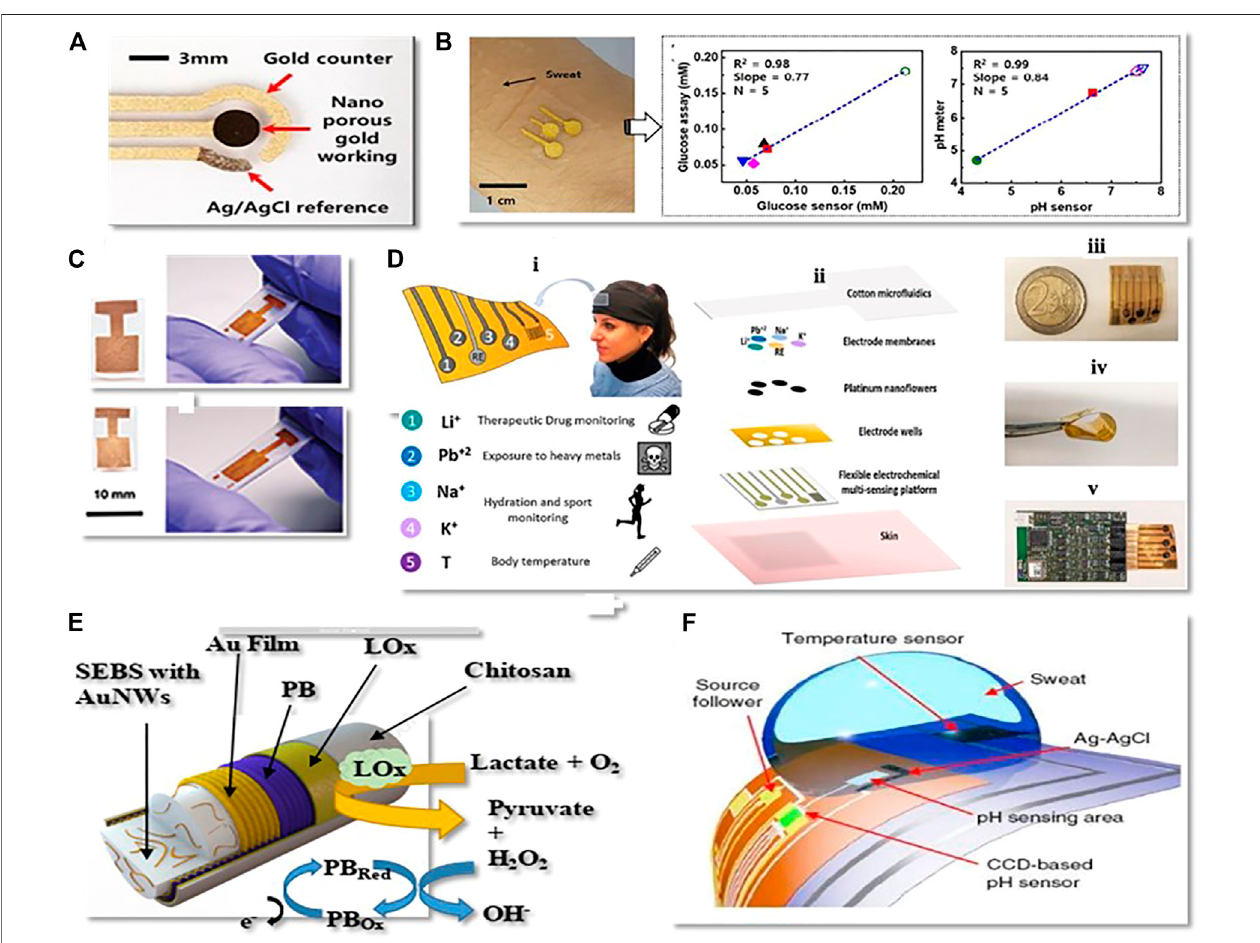
FIGURE 4 | (A) Gold nanoporous based non-enzymatic wearable biochemical sensor (Copyright 2019; American Chemical Society). (B) Gold nanosheet-based non-enzymatic wearable biochemical sensor (Copyright 2018; American Chemical Society). (C) Unshrunk gold electrode on polyole fi n (PO) and shrunk electrode on elastomer substrate (Copyright 2020; Advance Material and Technology). (D) Overview of the wearable multi-electrode device for sweat-based healthcare surveillance (Copyright2020;SensorsandActuators):(I)testationofhealthcareapplications;(II) fl exibleelectrochemicalmulti-sensingsystem;II) fl exiblemulti-electrodesensing platform; (IV) bending test; (V) example of interfacing with read-out electronics. (E) Lactate tracking electrochemical biosensor based on gold nano fi bers. (Copyright 2021; Journal of Materials Chemistry). (F) Ultrasensitive potentiometric biosensors based on Quasi-two-dimensional metal oxide semiconductors (Copyright 2018; Springer